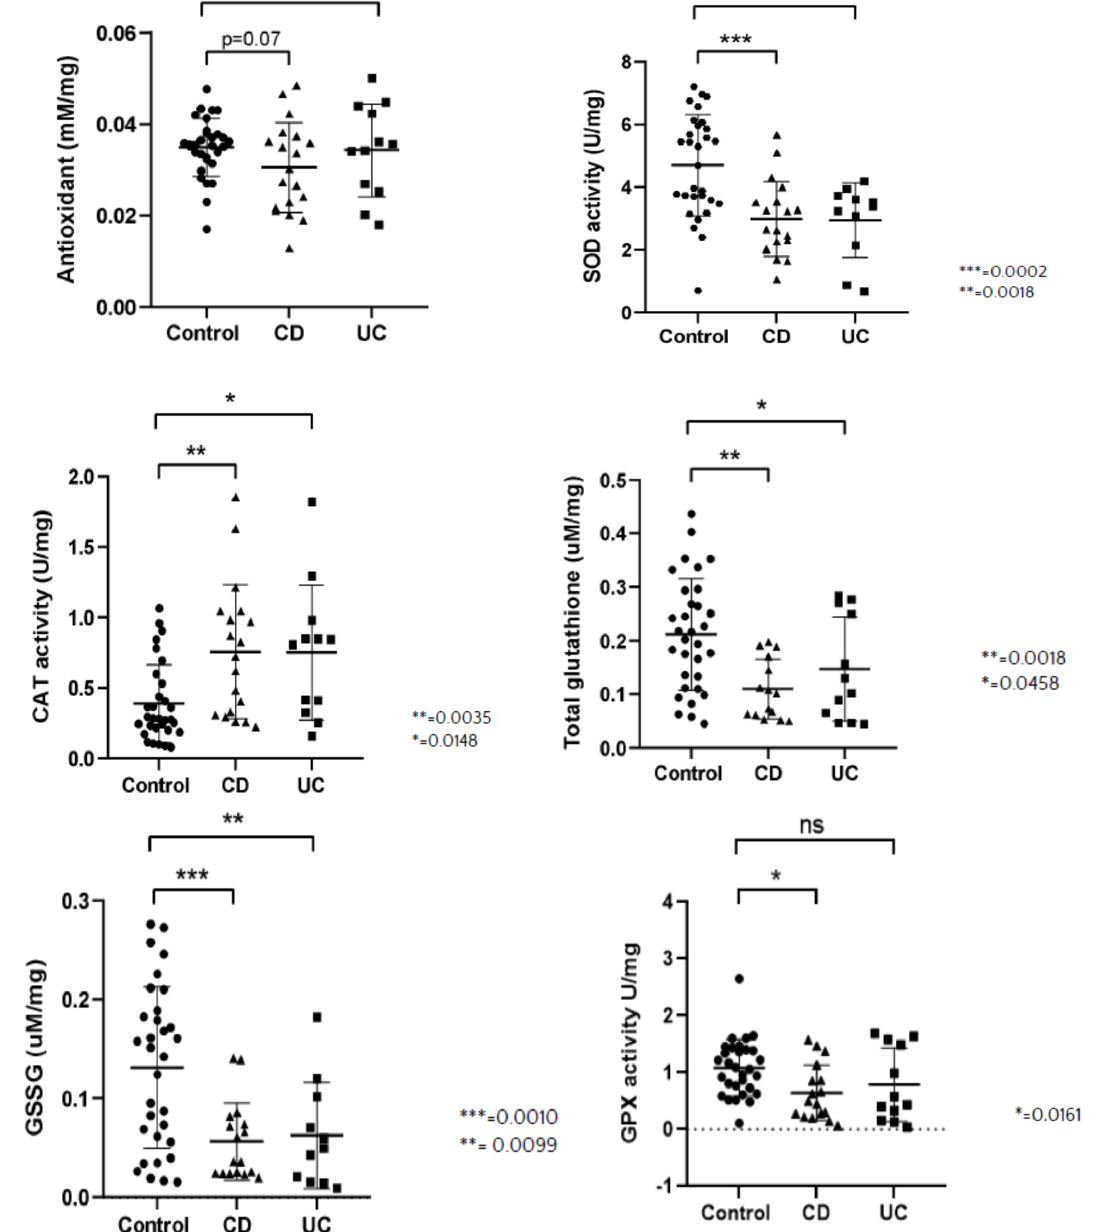
Figure 2. Total antioxidant concentration (TAC) (mM/mg sample), activity of superoxide dismutase (SOD, U/mg sample), activity of catalase (CAT, U/mg sample), concentration of total glutathione (GSH, uM/mg sample), concentration of oxidized glutathione (GSSG, uM/mg sample) and activity of glutathione peroxidase (GPX, U/mg sample) per milligram tissue sample in healthy subjects (Control), in patients with Crohn’s disease (CD) and ulcerative colitis (UC).